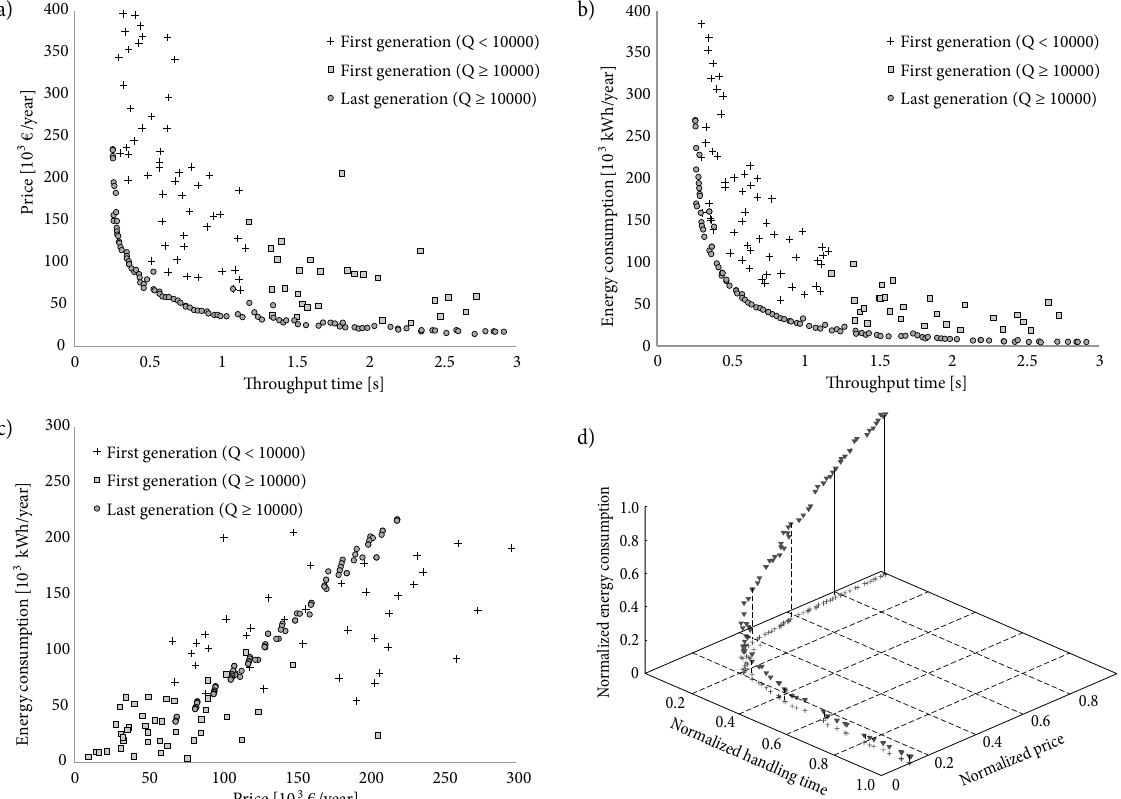
Fig. 4. Pareto optimisation results – Pareto front after 200 generations in terms of: a – cost and throughput time; b – energy consumption and throughput time; c – energy consumption and cost; d – normalised throughput time, normalised price (costs) and normalised energy